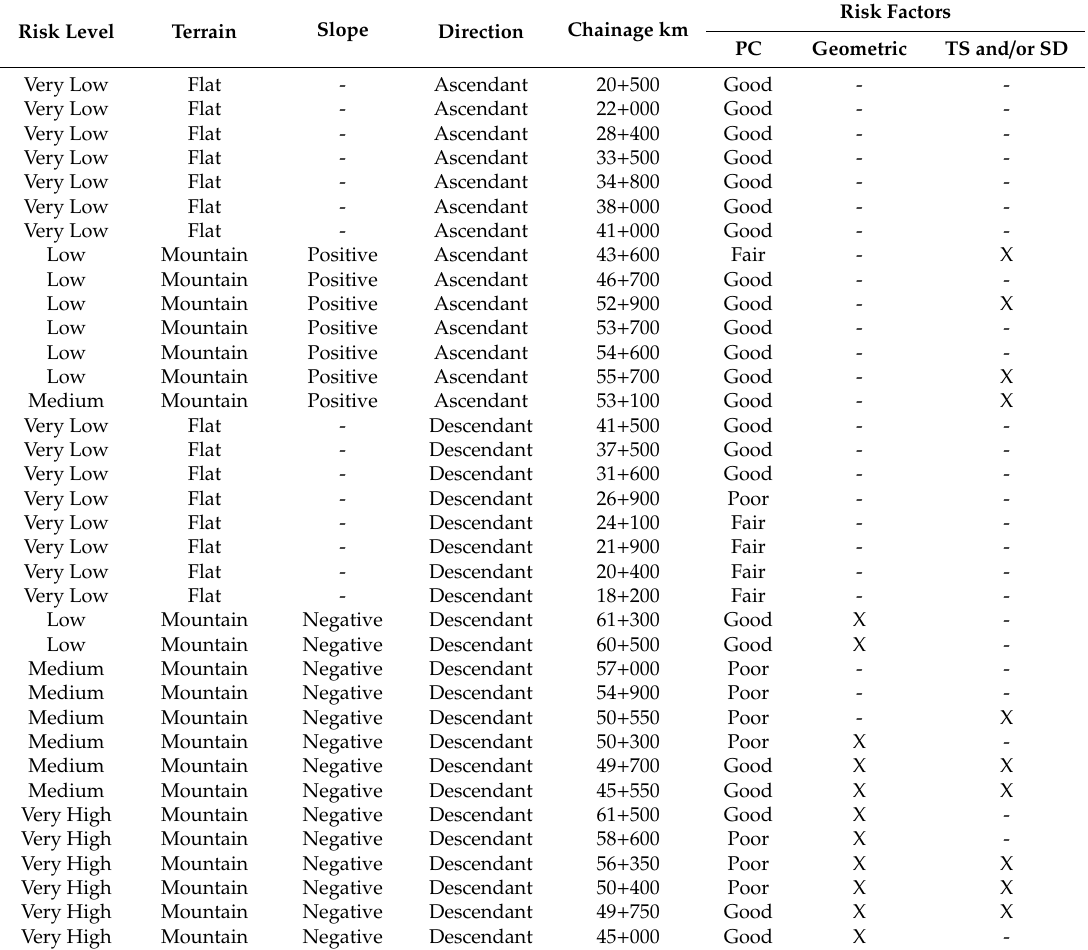
Table 7. Analysis of accident risk levels associated with risk factors 1